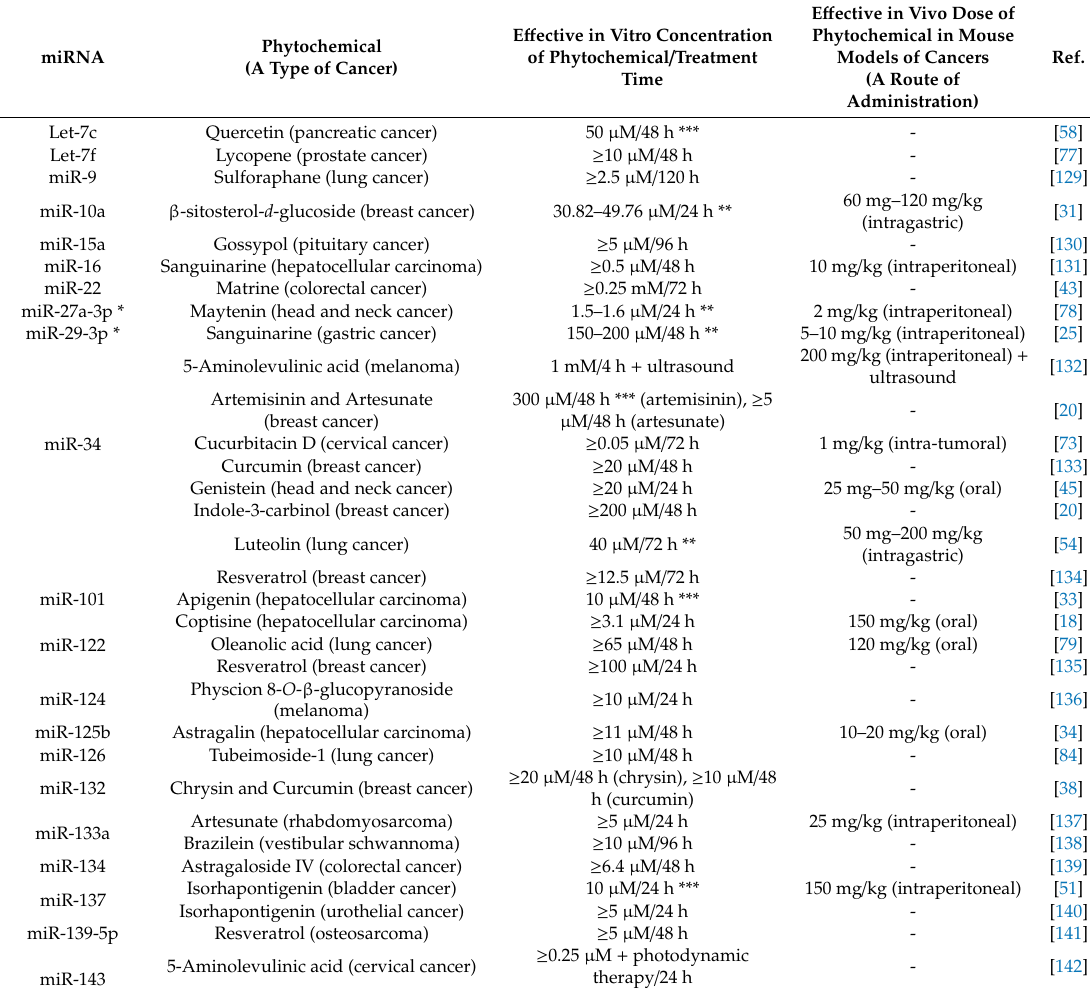
Table 4. Tumor-suppressive miRNAs modulated by phytochemicals.